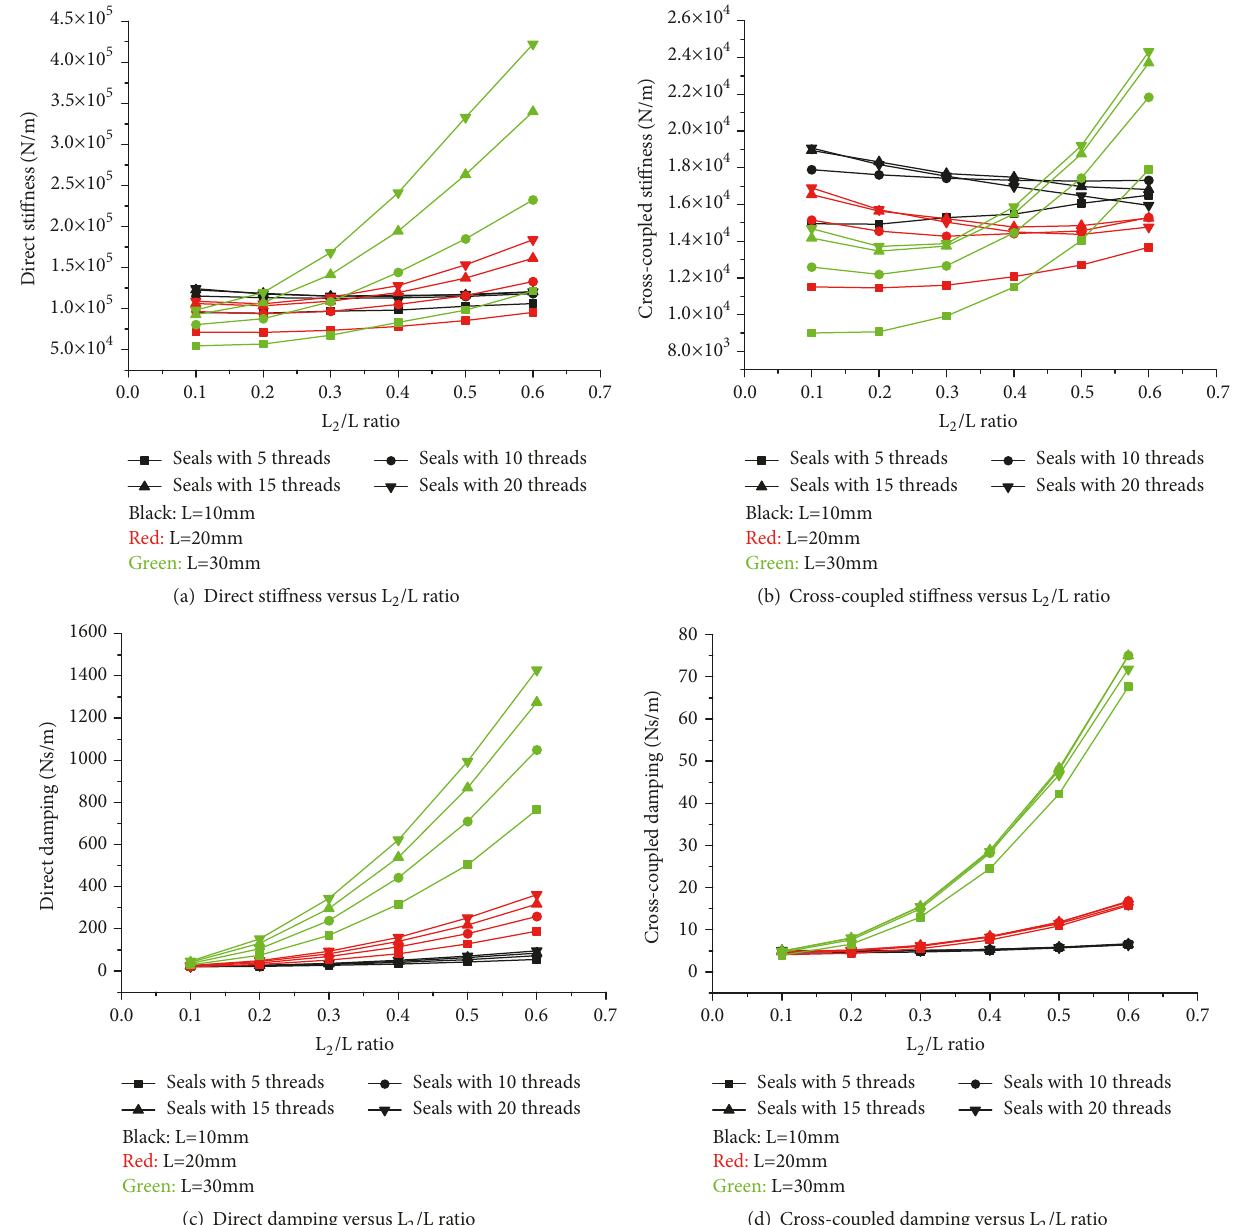
Figure 12: Dynamic characteristic changes versus L 2 /L